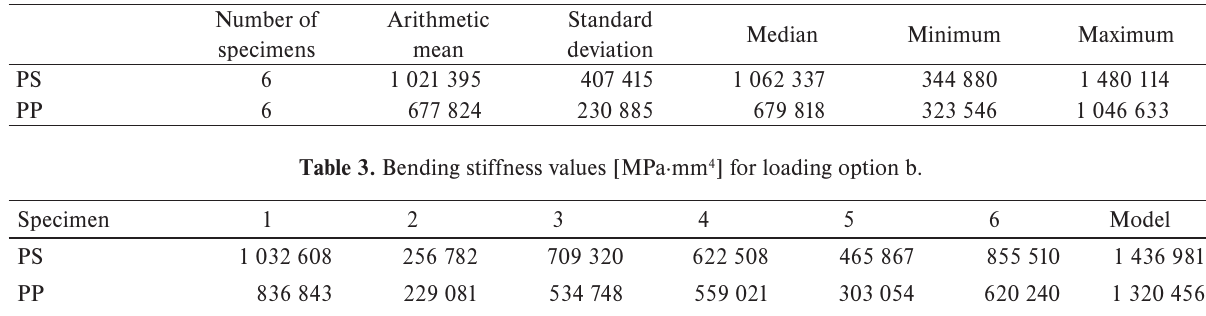
Table 2. Descriptive statistical data for bending stiffness in loading option a.